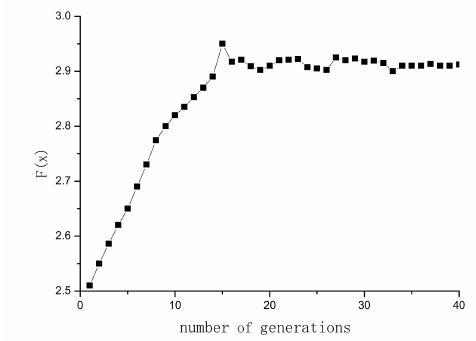
Figure 5. Objective function F(x) convergence process. The t 100 convergence process is as in Figure 6, basically stable after near 20 generations.